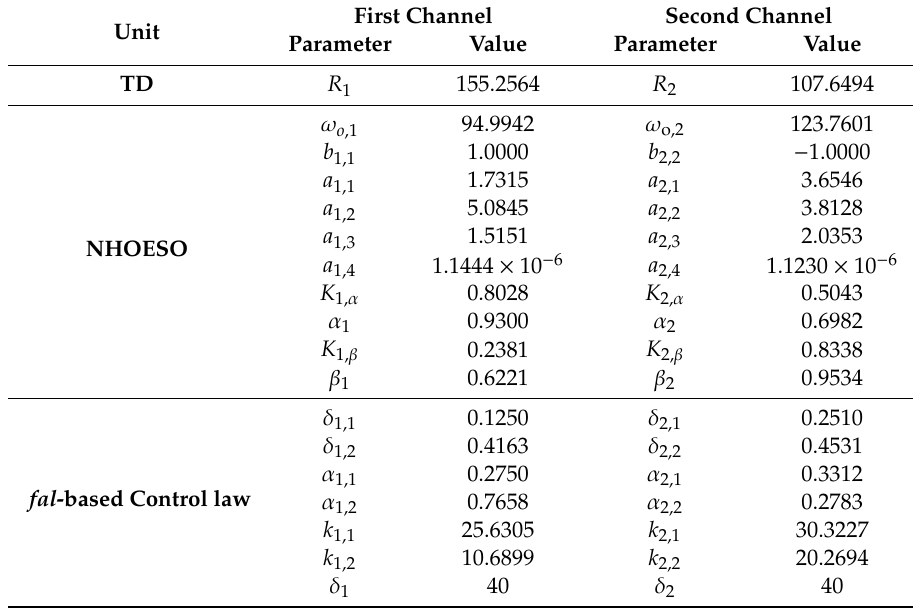
Table 5. The parameters of the second configuration (IADRC).